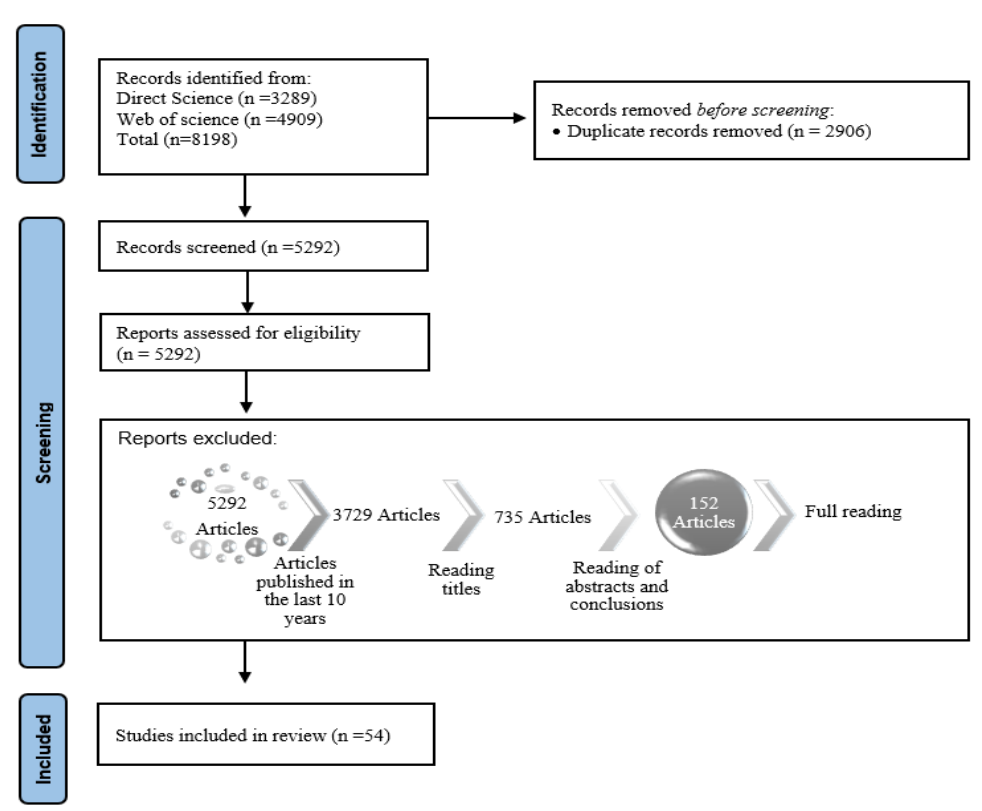
Table 1. Number of articles found in each filtering step based on keywords.